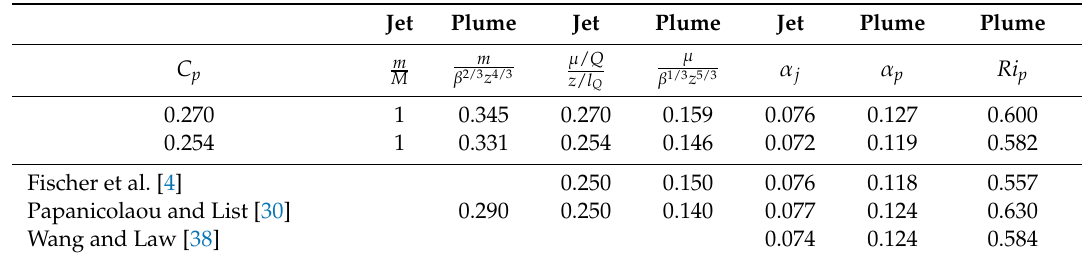
Table A1. Comparison between measured and computed parameters in vertical jets and plumes using our analytical solution (top-hat